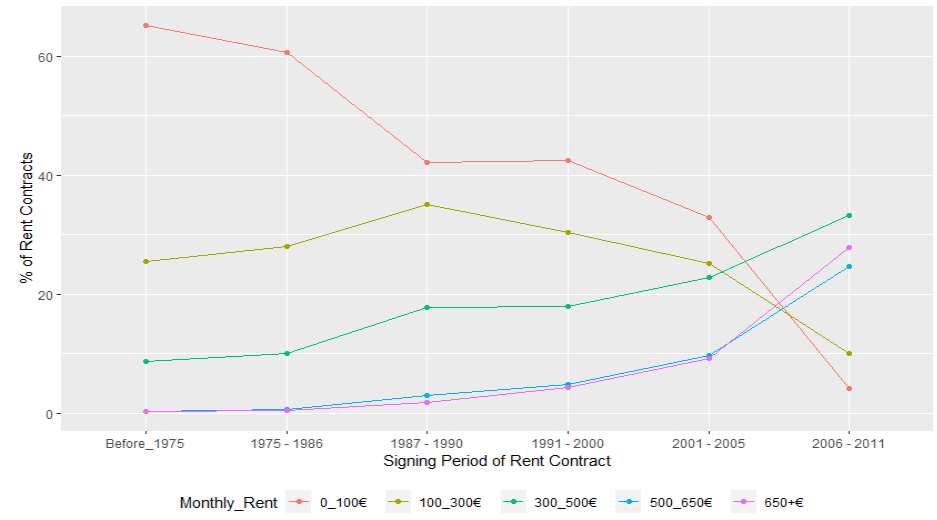
Figure 2. The growth of average monthly rent in Lisbon. Source: Own elaboration, with data from Census records 2011.